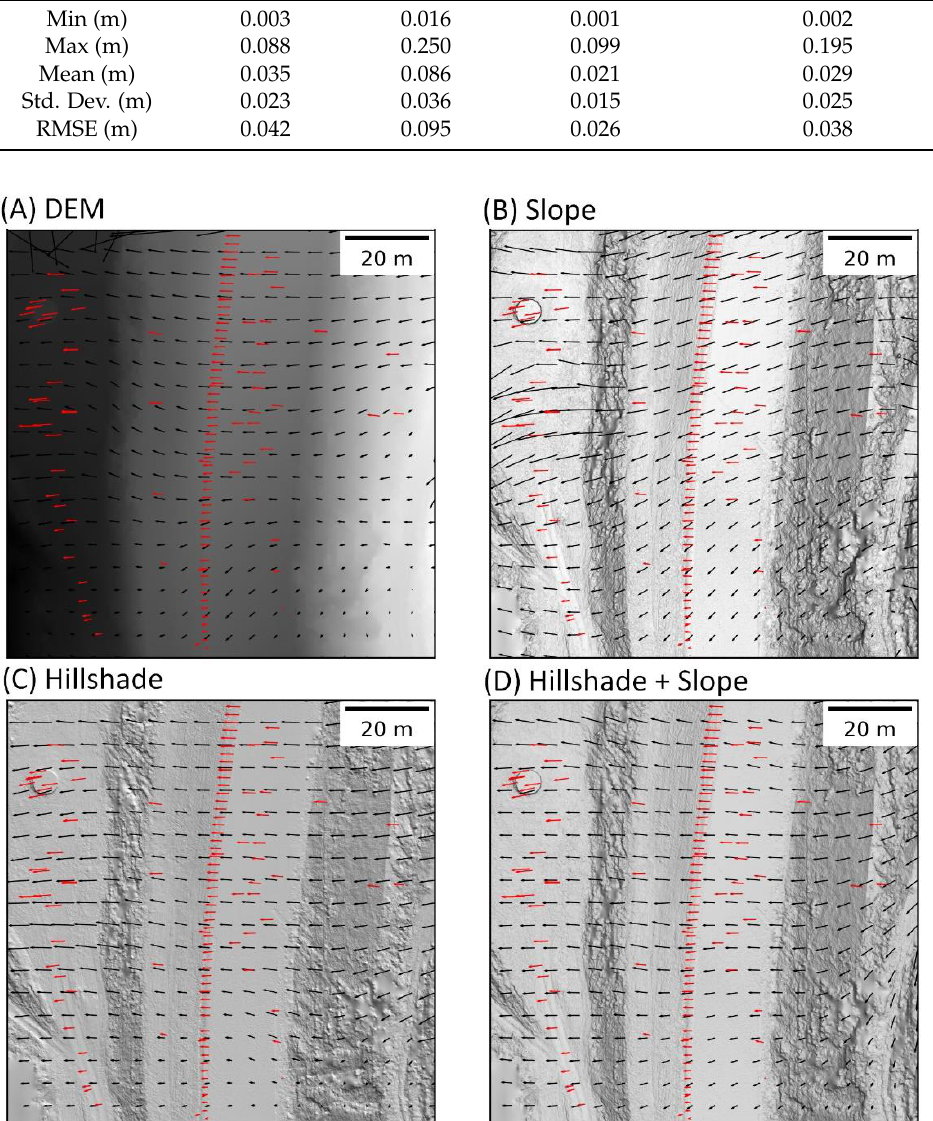
Figure 4. Visualization of the output 2D landslide displacement using 4 different DEM representa- tions: ( A ) Normalized DEM, ( B ) Slope, ( C ) Hillshade, and ( D ) Combined Hillshade and slope. Black vectors show the output 2D displacement vectors plotted every 100 cells, while the red vectors show the ground truth vectors measured from the ground truth dataset. All vectors are scaled 20×.